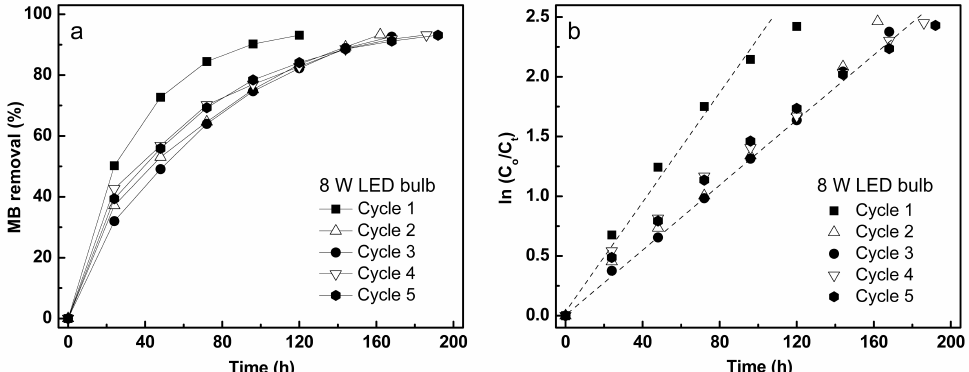
Figure 12. Photodegradation kinetics of MB under a commercial 8 W LED bulb: ( a ) MB removal and ( b ) normalized plot for pseudo-first-order.